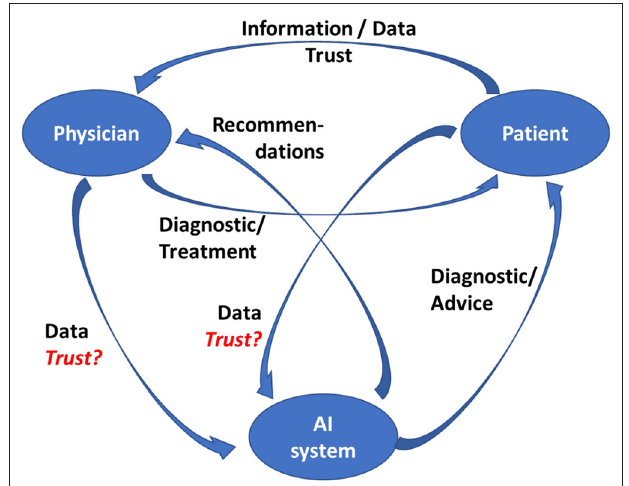
FIGURE 4 | Physician-patient-AI relationship.